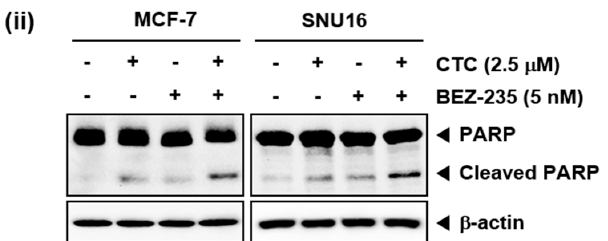
Figure 3. CTC suppresses EGF-stimulated Akt/mTOR signaling pathway. ( A ) MCF-7, SNU16, and RPMI 8226 cells were serum starved 12 h and treated with 5 µM of CTC for 9 h, followed by stimulation with 100 ng/mL of EGF for 15 min and western blot analysis was performed as described above in panel 1C. ( B ) The cells were treated with 2.5 µM of CTC alone or combined with 5 nM BEZ-235 for 9 h. Whole-cell extracts were prepared, and western blot analysis was performed as described above in panel 1C. ( C-i ) The cells were treated with 2.5 µM of CTC alone or in combination with 5 nM BEZ-235 for 24 h and TUNEL staining done as described in panel 2B-ii above. ( C-ii ) The cells were treated with 2.5 µM of CTC alone or combined with 5 nM BEZ-235 for 24 h and western blot analysis